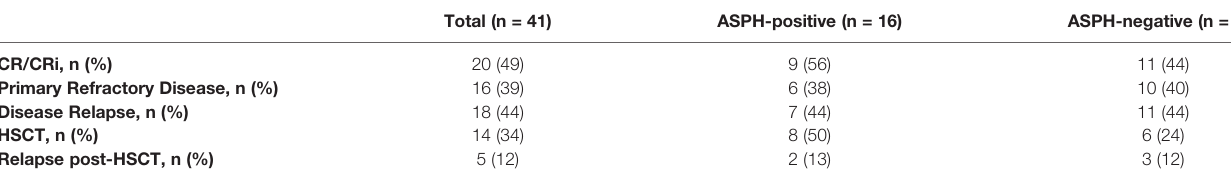
TABLE 2 | Treatment response and clinical outcomes.